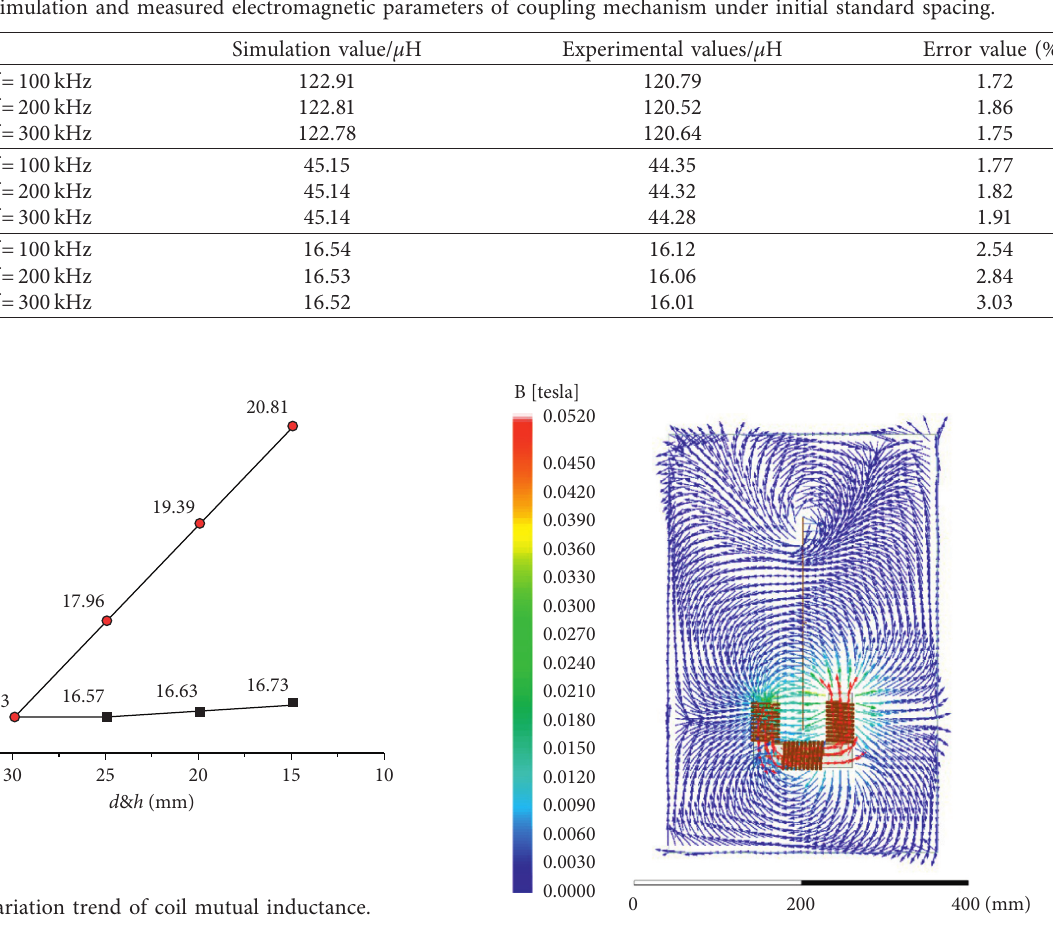
Figure 6: Distribution of magnetic induction